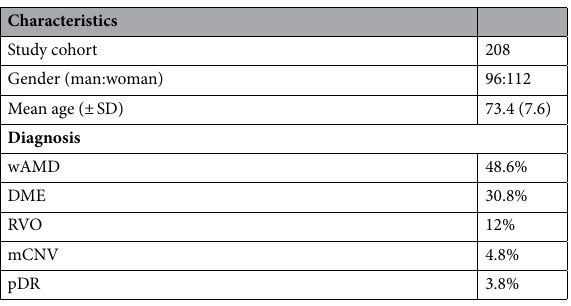
Table 1. Baseline and demographic characteristics of the study cohort. SD standard deviation, WAMD wet age-related macular degeneration age-related macular degeneration, DME diabetic macular edema, RVO retinal vein occlusion, mCNV myopic choroidal neovascularization, pDR proliferative diabetic